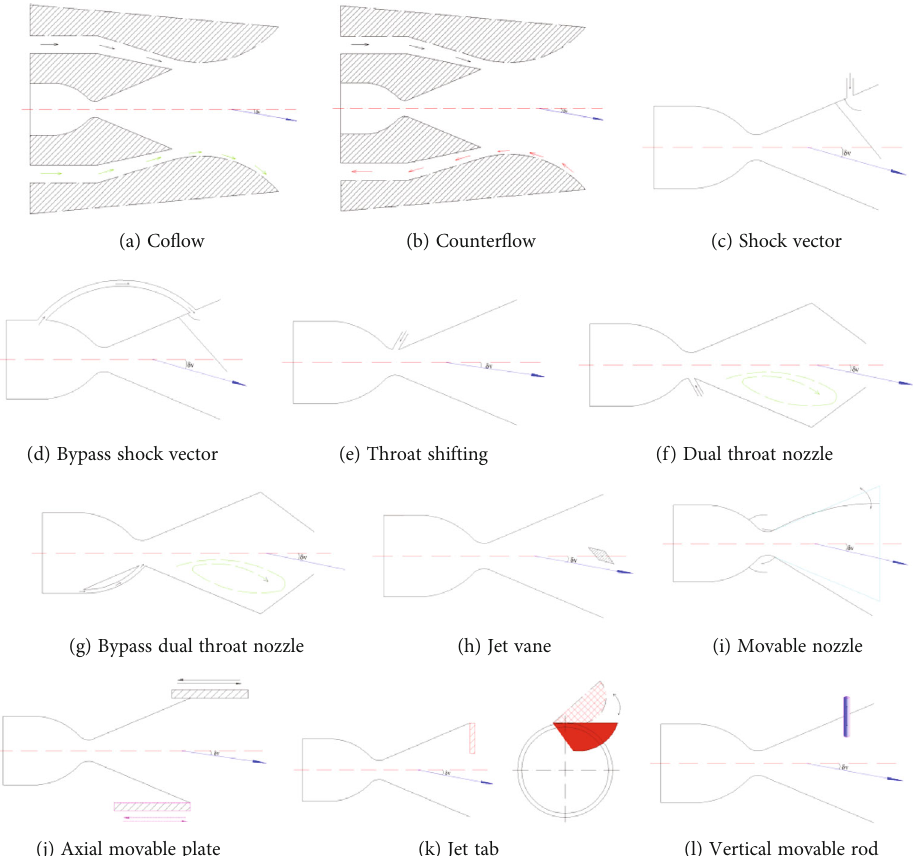
Figure 1: Fluidic and mechanical thrust vector control